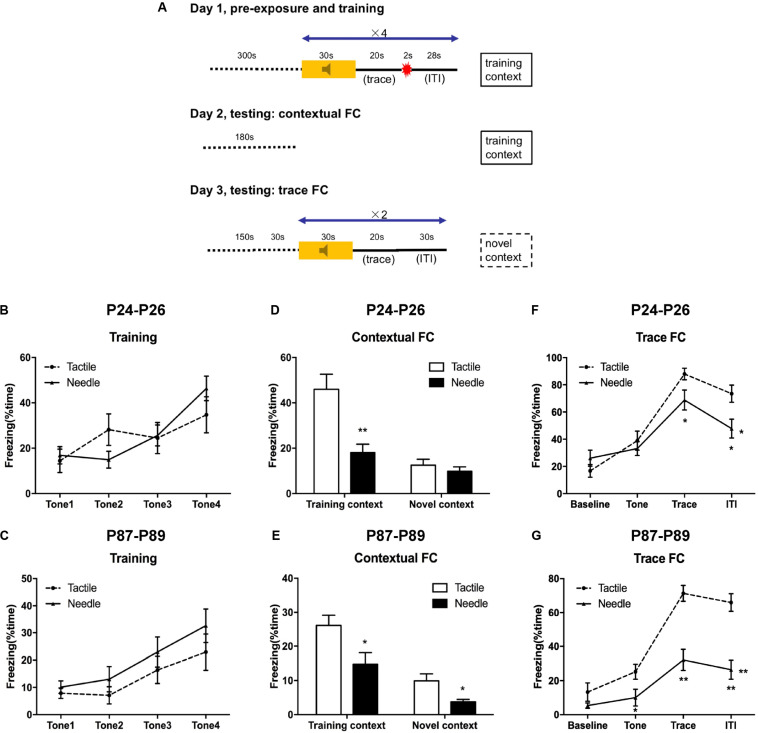
Traced fear conditioning (FC) performance. (A) Experimental protocol. A repeated ANOVA was used to determine the significance of differences in freezing behavior between the two groups during the training phase (B,C) and trace FC phase (F,G). Group differences at certain time points were determined by the least significant difference (LSD) post hoc test. An independent t-test was used to detect group differences in the contextual FC phase (D,E). Data are expressed as the mean ± SEM. *P < 0.05, **P < 0.01 for needle group vs. tactile group. P24: n (tactile group) = 12, n (needle group) = 15; P87: n = 17. ITI, intertrial interval.